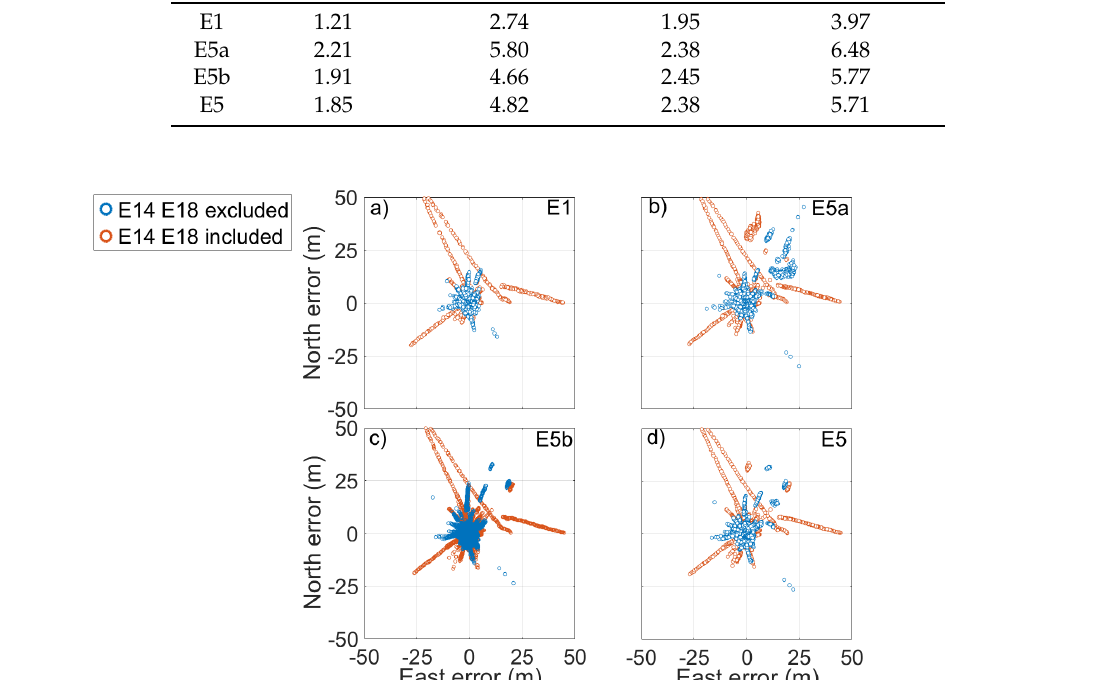
Table 2. RMS comparison between two scenarios (including or excluding the Milena (E14) and Doresa (E18) satellites) analyzed. Broadcast ephemeris was used. DRMS, Distance Root Mean Squared. Freq.